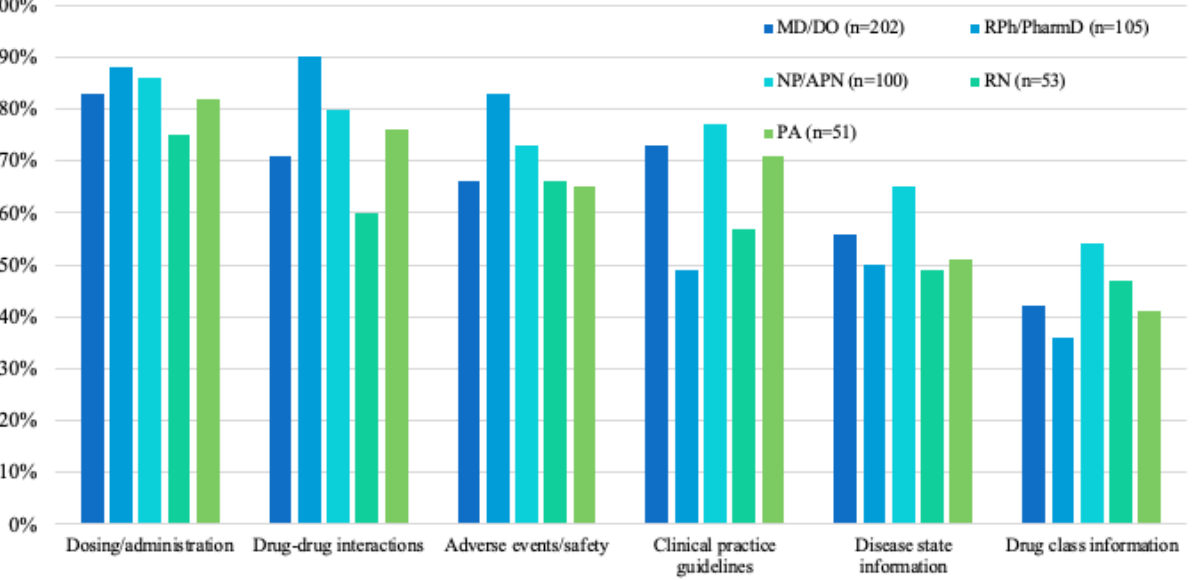
Figure 2. Information typically sought by healthcare professionals. APN: advanced practice nurse; DO: Doctor of Osteopathic Medicine; MD: medical doctor; NP: nurse practitioner; PA: physician assistant; PharmD: Doctor of Pharmacy; RN: registered nurse; RPh: registered